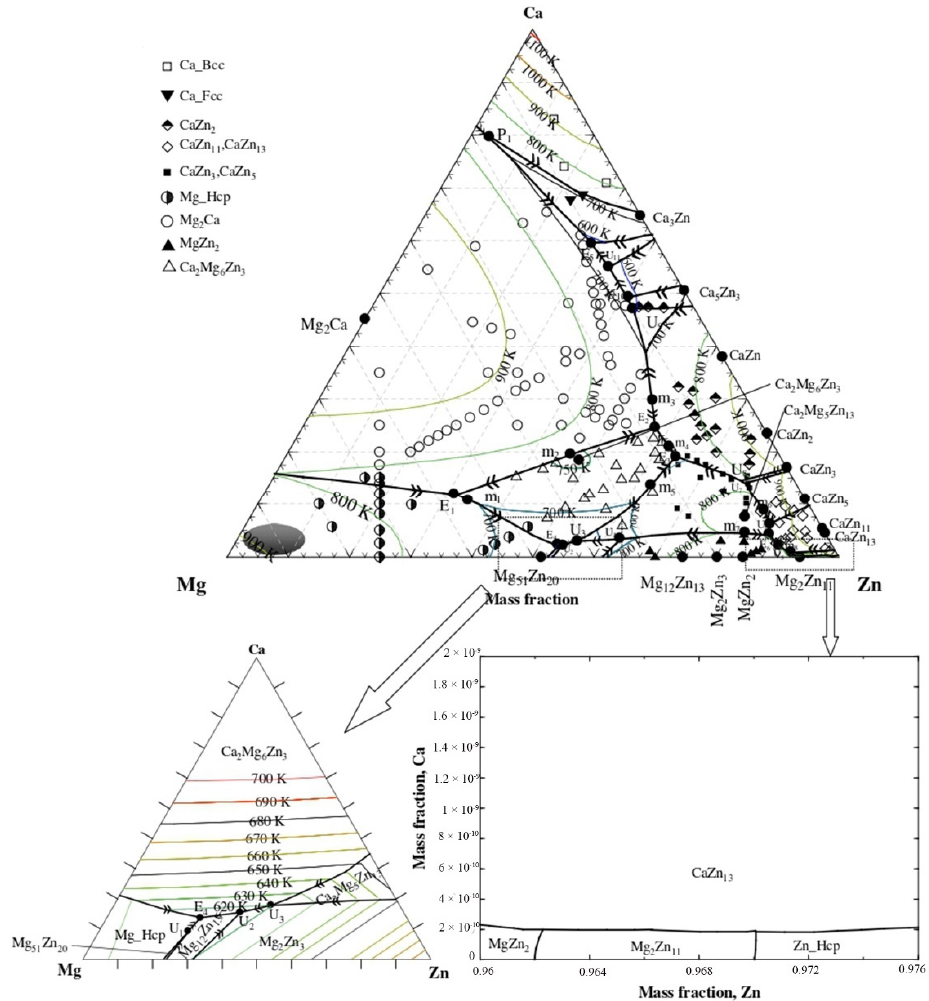
Figure 5. Mg–Zn–Ca ternary diagram. Reprinted with permission from Ref. [33,34].